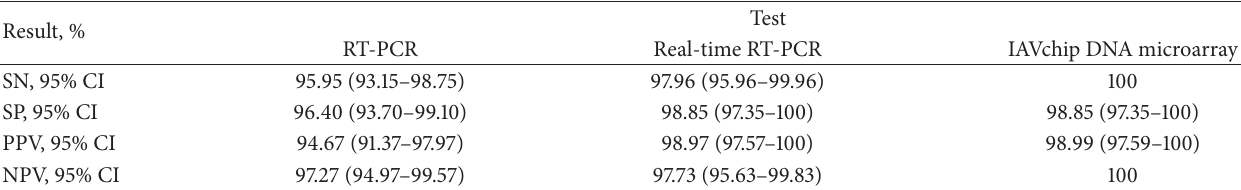
Table 4: Comparative diagnostic value of different tests in influenza A